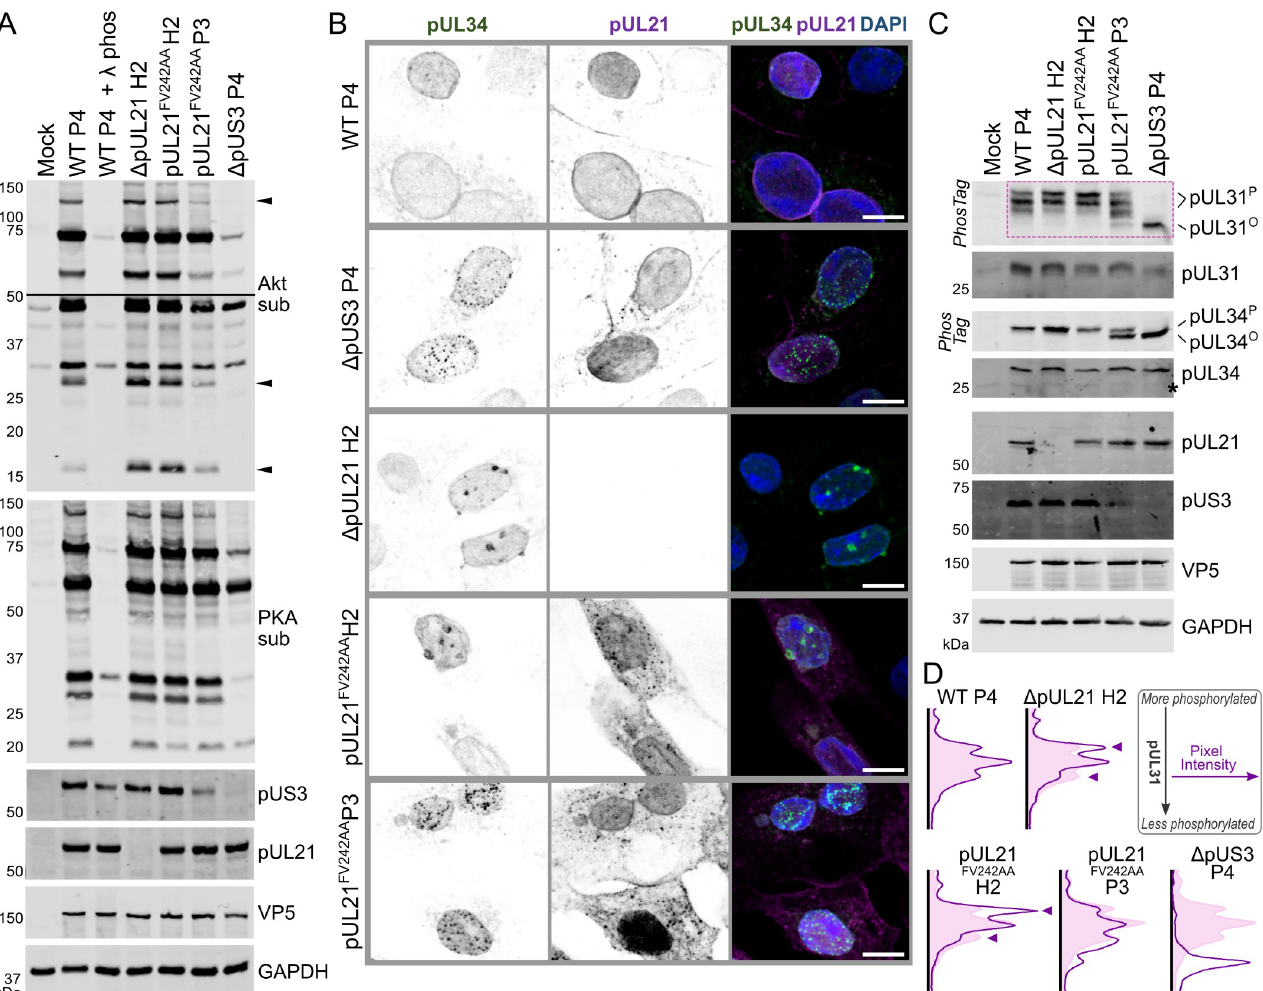
Fig 6. pUL21 antagonises pUS3-mediated protein phosphorylation and NEC distribution. ( A ). Vero cells were infected at MOI = 5 with wild-type (WT) or mutant HSV-1 that had been prepared following amplification of the original rescued stock for three or four generations in Vero cells (P3 and P4, respectively) or for two generations in HaCaT pUL21 cells (H2). Lysates were harvested at 16 hpi and subjected to SDS-PAGE plus immunoblotting. With the exception of the lysate from WT HSV-1 infected cells that was treated with lambda phosphatase ( λ phos), all lysates were harvested in the presence of phosphatase inhibitors. Immunoblots were probed with the antibodies shown. Antibodies recognising phosphorylated Akt and PKA substrates (sub) illustrate the activity of pUS3, as the specificity of this viral kinase overlaps with those of cellular kinases Akt and PKA [47,48].For the Akt sub immunoblot two exposures are shown, separated by a line, and phosphorylated Akt substrates more abundant in cells infected with virus lacking pUL21 that can recruit PP1 ( Δ pUL21 and pUL21 FV242AA H2) are marked with arrowheads. ( B ) Vero cells were infected at MOI = 1 with WT or mutant HSV-1, prepared as in ( A ). Cells were fixed at 10 hpi and stained using antibodies that recognise pUL34 (green) and pUL21 (magenta). The merge includes DAPI (blue) and the scale bar represents 10 μ m. ( C ) Vero cells were infected at MOI = 5 with WT or mutant HSV-1 as listed. Lysates were harvested at 16 hpi and subjected to SDS-PAGE plus immunoblotting using the antibodies listed. The upper strips of the pUL31 and pUL34 blots depict SDS-PAGE where PhosTag reagent was added to enhance separation of hyperphosphorylated (pUL31 P and pUL34 P ) and hypophosphorylated (pUL31 O and pUL34 O ) forms of the proteins. Non-specific bands are indicated with an asterisk ( � ). Boxed region denotes pUL31 bands used for quantitation in ( D ). ( D ) Relative abundance of pUL31 phosphoforms. Two-dimensional intensity profiles of pUL31 immunoblots following PhosTag SDS-PAGE ( C ), calculated by averaging horizontal pixel intensities for each lane (arbitrary units) along the vertical axis, are shown as purple curves. The intensity profile for pUL21 WT P4 infected cells is shown for comparison as a pink filled curve. Prominent differences in the profiles for cells infected with virus lacking pUL21 that can recruit PP1 ( Δ pUL21 and pUL21 FV242AA H2) are denoted with arrowheads. observed in HaCaT cells infected with the same panel of viruses (S5A Fig). This confirms that the mutations observed in the adapted virus impair pUS3 kinase activity and suggests that pUL21 may directly antagonise the pUS3 activity for some substrates.